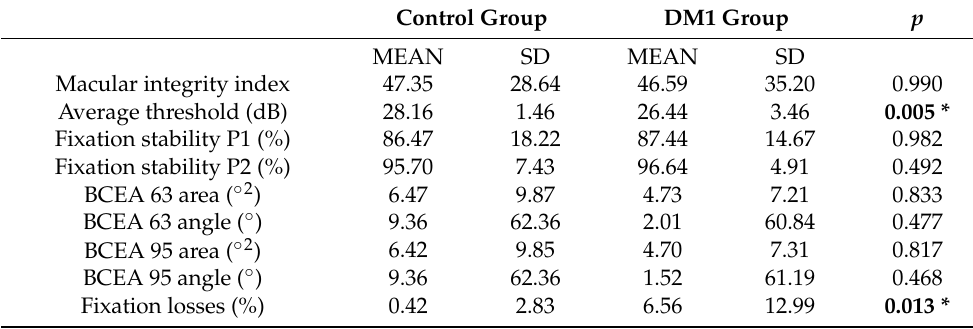
Table 2. Mean and standard deviation (SD) of the rest of the parameters that the MAIA microperime- ter offers for the control group and the DM1 group and a comparison between the values of both groups. The statistically significant values shown in bold and with an asterisk ( p < 0.05). BCEA, Bivariate contour ellipse angle. The macular integrity and average threshold are measured in dB, the BCEA angle is measured in degrees, the area is measured in square degrees and fixation loses, P1, P2 are reported in %.